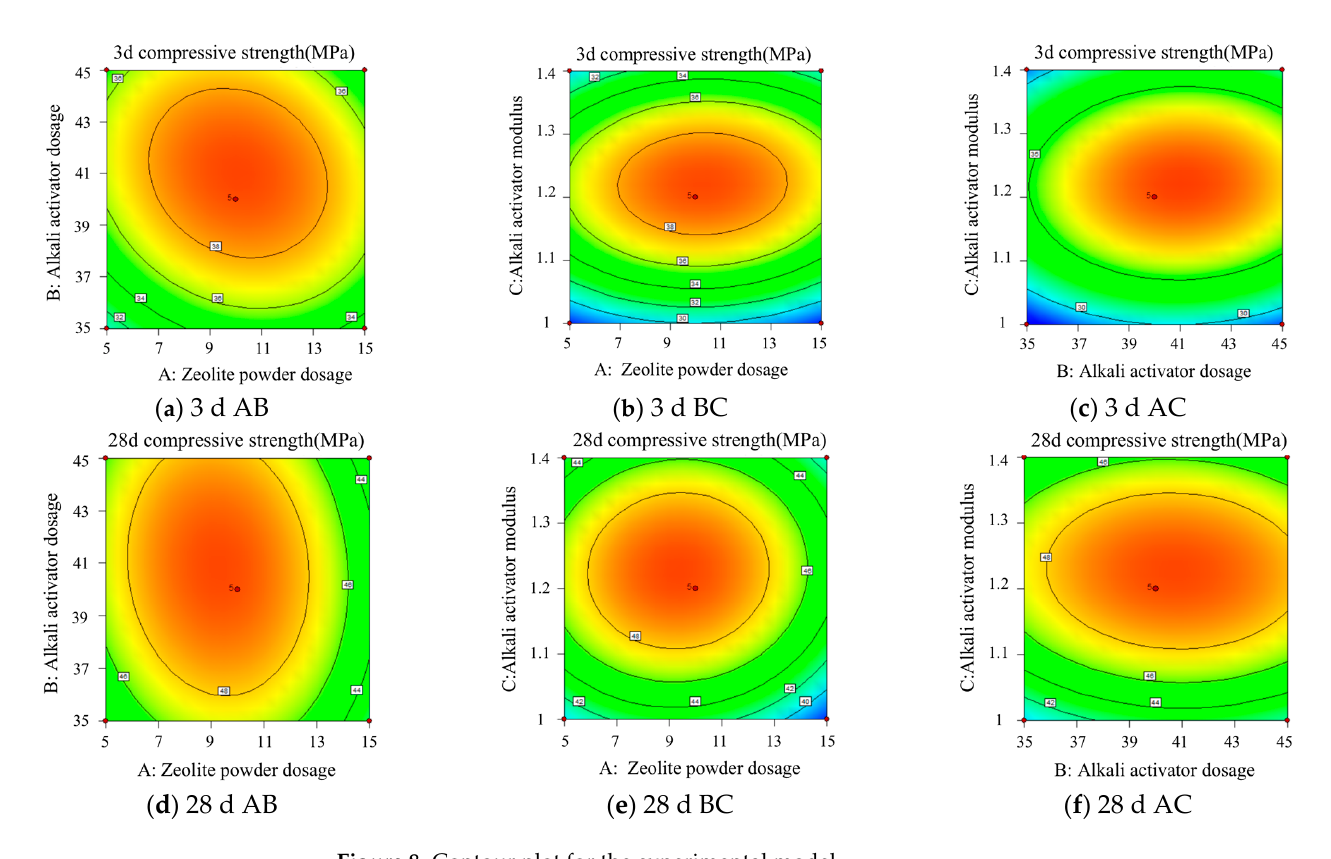
Figure 7. Response surfaces for the experimental model.